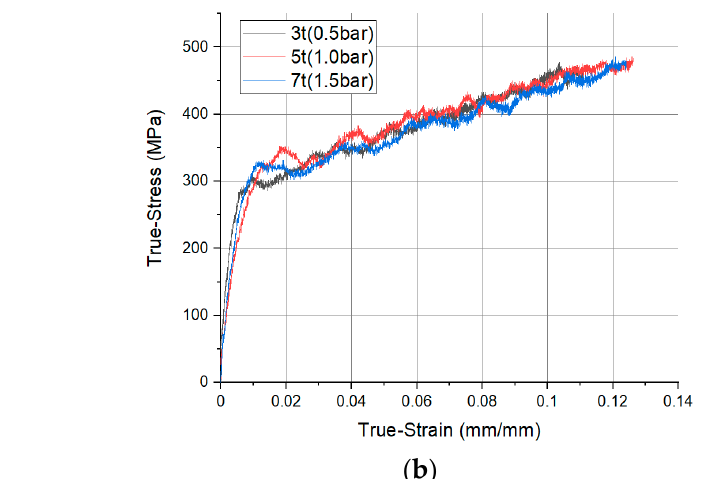
Figure 12. Comparison of the strain and strain rate results under different test conditions.